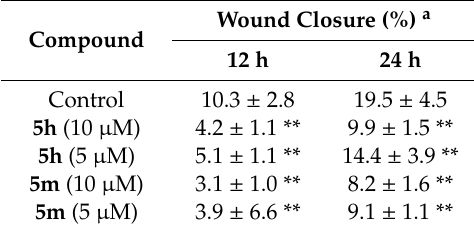
Table 4. Binding energies of compounds 5h and 5m with the PI3K α and PI3K β enzymes.